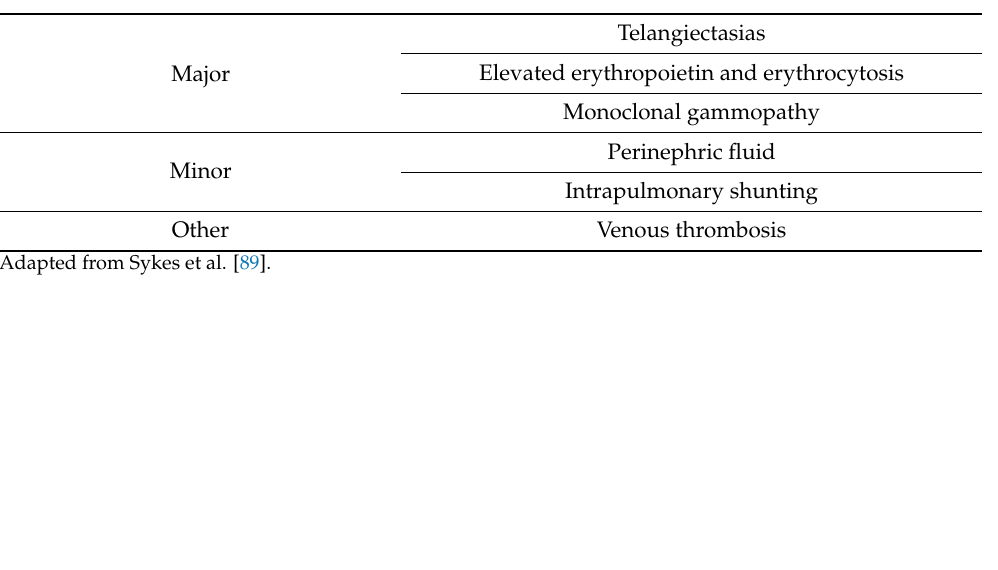
Table 9. TEMPI syndrome diagnostic